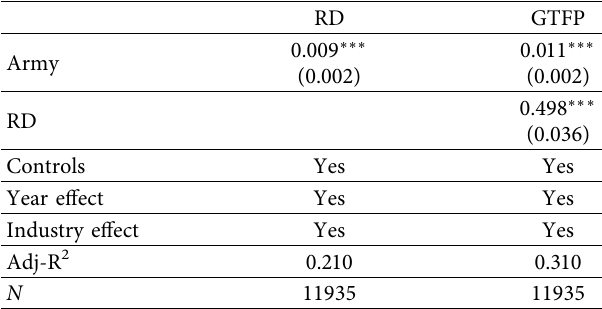
Table 7: Mechanism efect